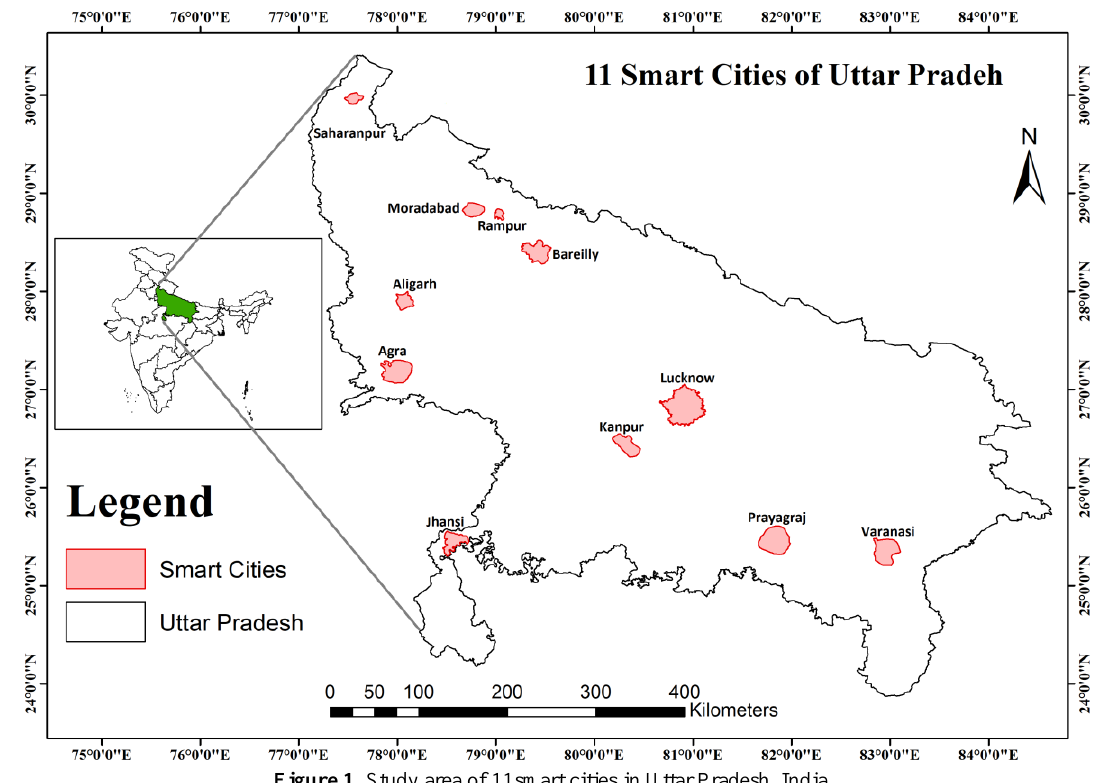
Figure 1 . Study area of 11smart cities in Uttar Pradesh,